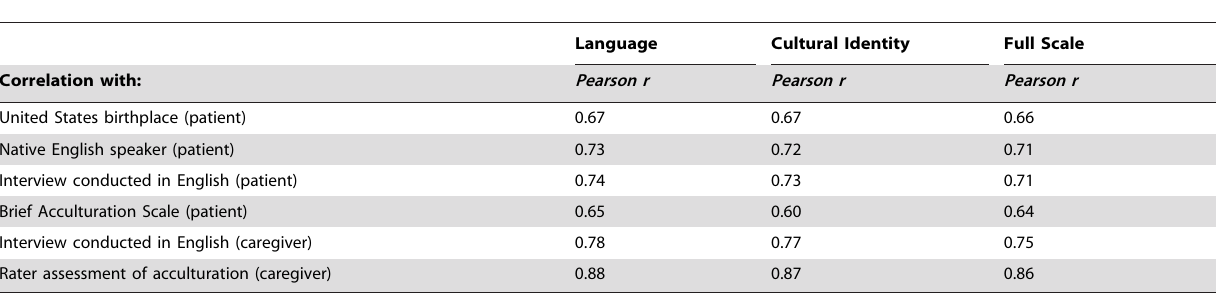
Table 3. Summary of validity analyses for caregiver United States acculturation scale.